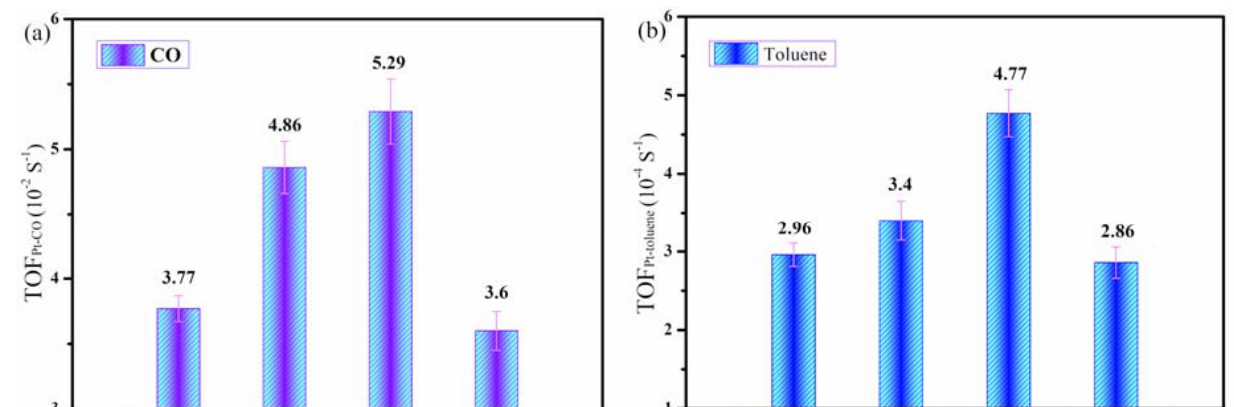
Figure 6. ( a ) CO and ( b ) toluene conversions in simple conditions of these Pt/Al 2 O 3 and Pt ‐ M/Al 2 O 3 samples; ( c ) CO and ( d ) toluene conversion in mixture conditions of these Pt/Al 2 O 3 and Pt ‐ M/Al 2 O 3 samples. Simple conditions: 1.0 vol.% CO or 1000 ppm toluene balanced with air; Mixture conditions: 1.0 vol.% CO and 1000 ppm toluene balanced with air. All the reactions were kept at WHSV = 60,000 mL g − 1 h − 1 .